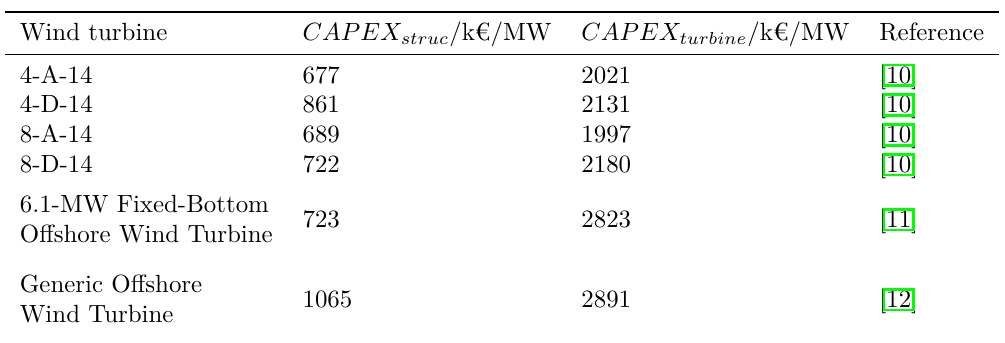
Table 1. CAPEX of different offshore wind turbines divided into a structural and a turbine